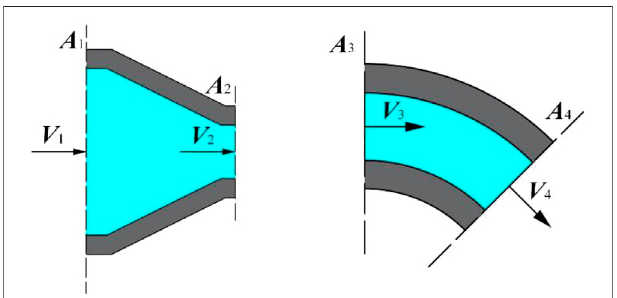
FIGURE 5 | Control body of the curved-tube nozzle. (A) Control body of shrinkage tube. (B) Control body of bend